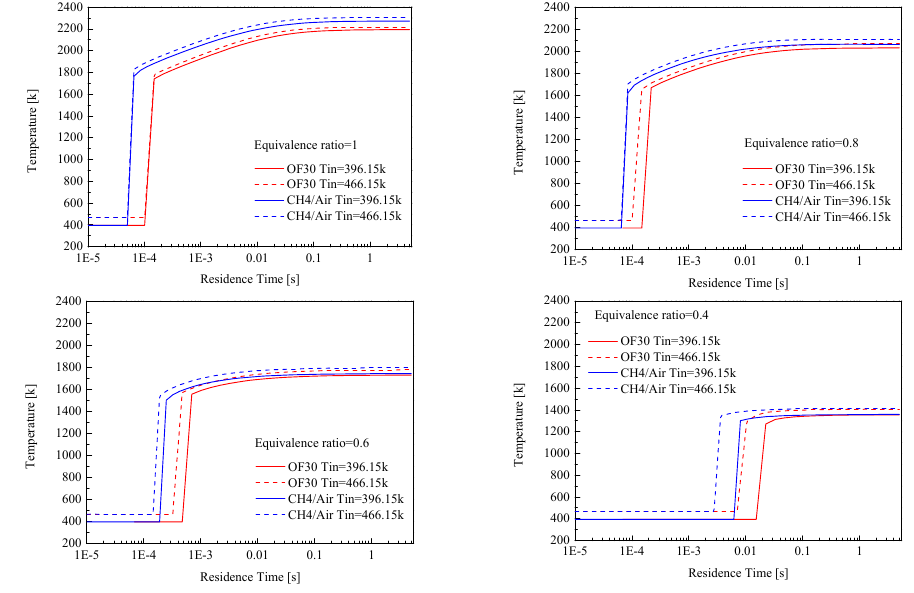
Figure 9. Dependence of CH 4 /air and OF30 adiabatic flame temperature on residence times. Four equivalence ratios (1, 0.8, 0.6, and 0.4) were examined at preheating temperatures of 396.15 and 466.15 K.